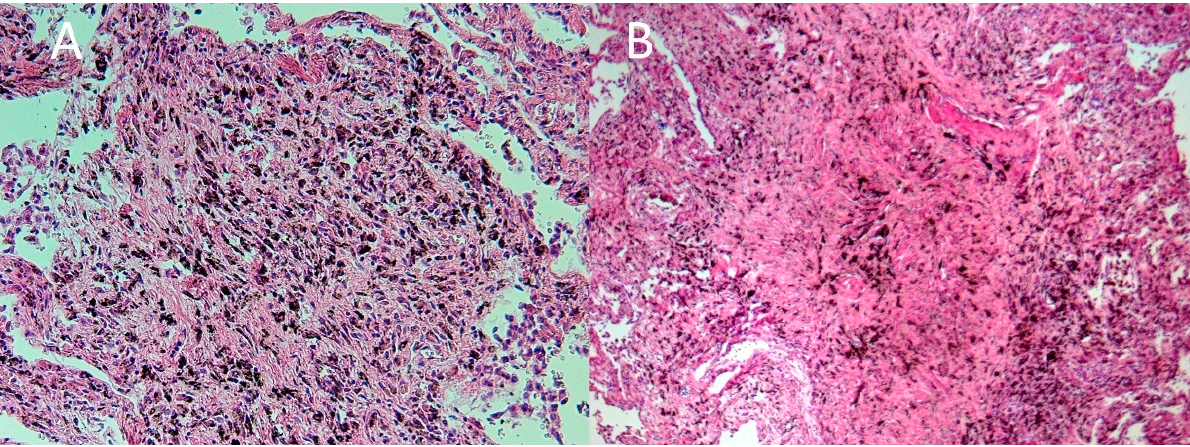
Int. J. Environ. Res. Public Health 2022 , 18 , x FOR PEER REVIEW Figure 4. Expression of P protein in glomeruli of the kidney. Magnification × 200. EnVision stain.